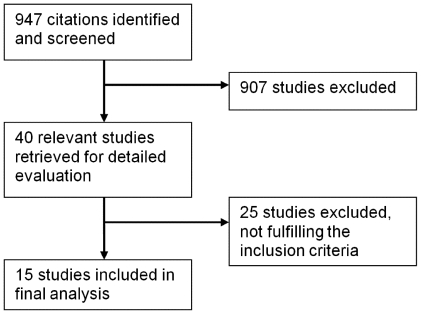
Flow diagram showing the number of citations identified, retrieved and included in final analysis.